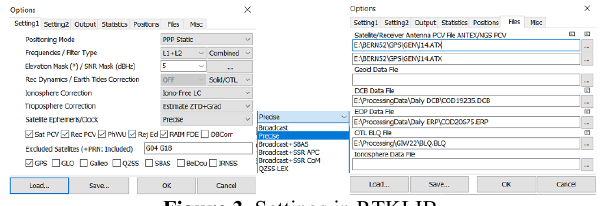
Figure 3. Settings in RTKLIB